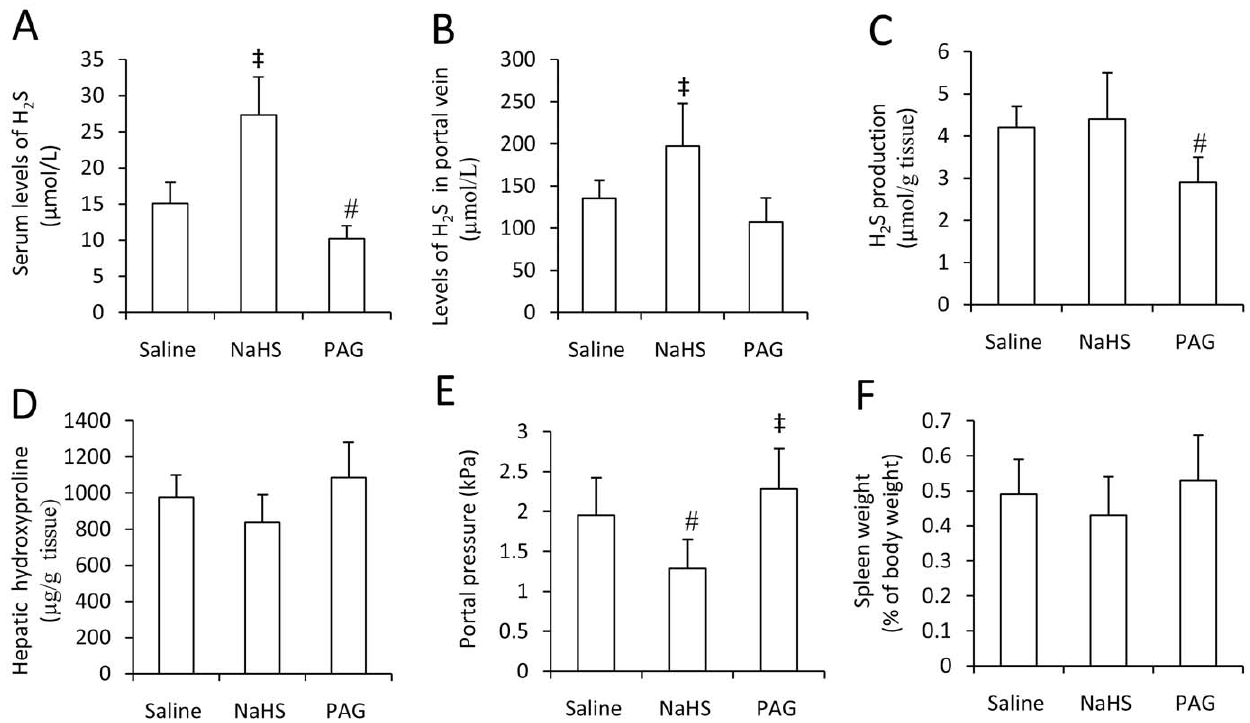
Figure 4. H 2 S levels and production, hepatic hydroxyproline, portal pressure and spleen weight in the treatment experiment. Liver cirrhosis was induced in rats as in Figure 3, and then the rats were assigned to three groups (Each group had 6 rats), and received daily injection of saline, NaHS or PAG, respectively, for 5 days, and then killed. (A) Blood samples were collected and the serum levels of H 2 S were measured. (B) Blood samples were collected from portal vein to measure the levels of H 2 S in portal vein (B). The hepatic H 2 S producing activity (C) and hydroxyproline contents (D) were measured. The portal pressure was measured (E), and each spleen was weighed as % of bodyweight (F). Results are expressed as mean 6 SD. A significant increase from saline-treated rats is denoted by ‘‘ { ’’, and a significant reduction by ‘‘ #